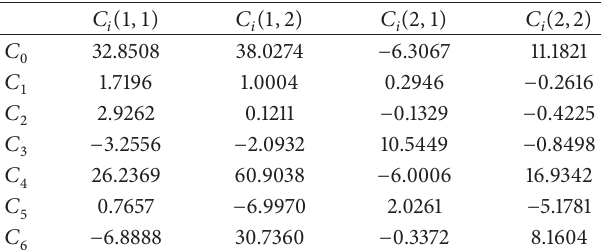
Table 1: Aerodynamic force coefficients of the typical aeroelastic case.